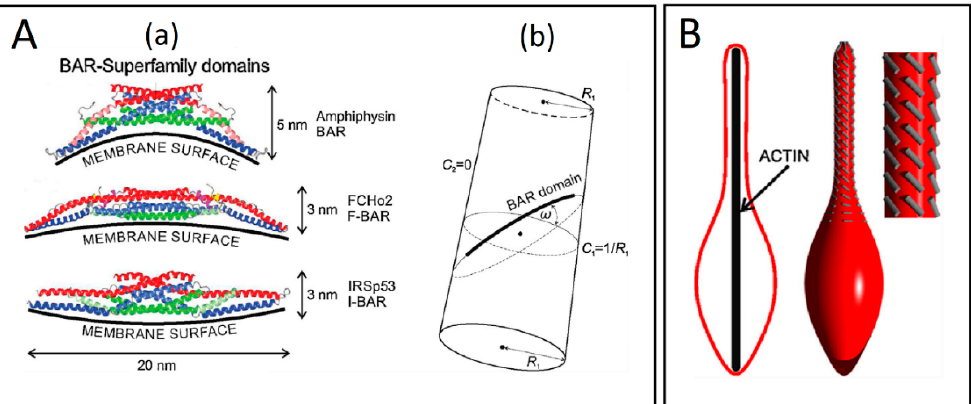
Figure 7. ( A ) Schematic presentations of the BAR superfamily domains and the cylindrical surface with the attached rod-like BAR domain. ( a ) The BAR domains are presented with their typical dimensions and curvature preferences. ( b ) The flexible rod-like BAR domain attached to the membrane surface of the cylindrical shape, where R1 is the radius of a cylinder. Angle ω is the angle between the normal plane of the first principal curvature C 1 and the normal plane in which the BAR domain is lying. C 2 is the second principal curvature (adapted from Reference [69]). ( B ) The impact of external force on the orientation of BAR domains. The lateral orientation of the membrane attached BAR domains (grey lines) is changed, when the vesicle is elongated by external force, which may result from the action of a growing cytoskeleton inside of the vesicle (adapted from Reference [69]).